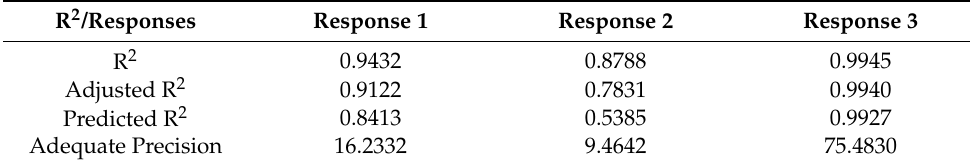
Table 4. Regression relation for elastic modulus, hardness, and weight loss. R 2